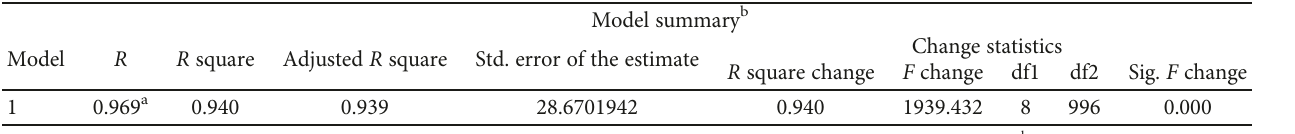
Table 8: Model summary.